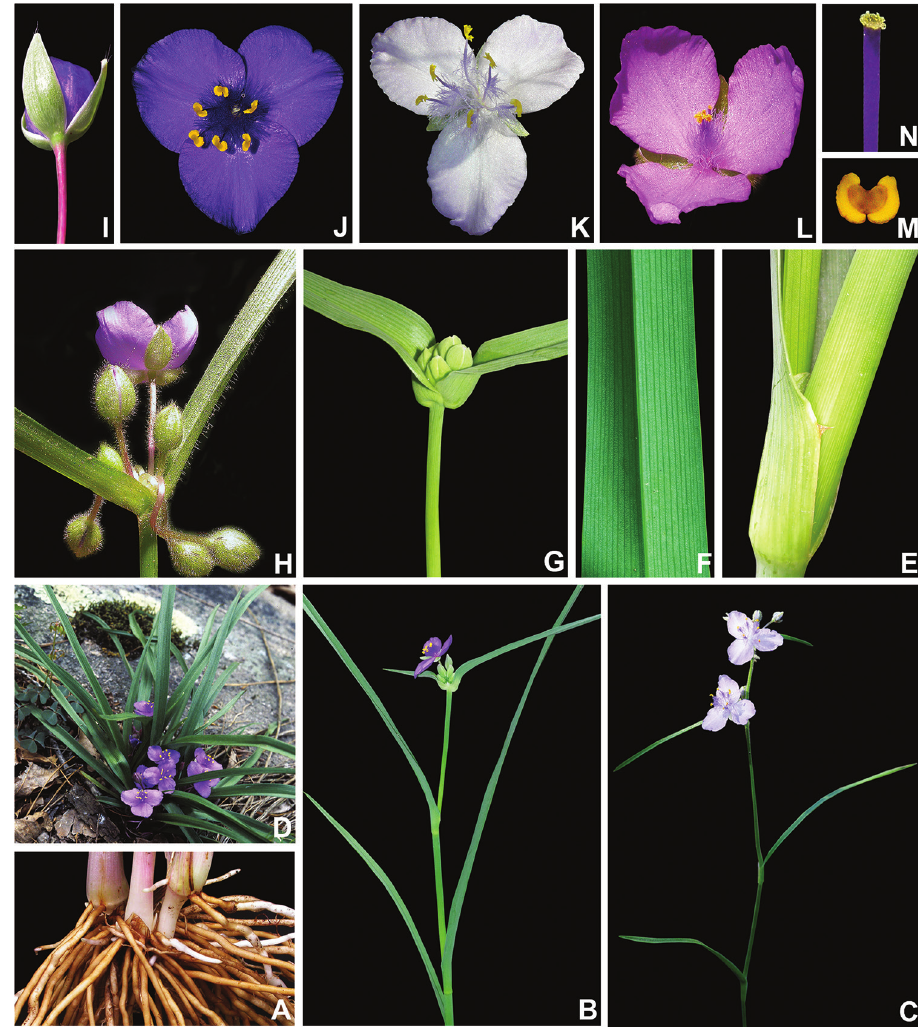
Figure 14. Tradescantia L. subg. Tradescantia . A tuberous roots of T. ohiensis Raf. B–D habit: B erect robust habit of T. ohiensis C erect delicate habit of T. pinetorum Greene D rosette habit of T. longipes E.S.Anderson & Woodson. E, leaf-sheath split at maturity of T. ohiensis F detail of the leaf-blade of T. ohiensis , showing the conspicuous secondary veins G–H inflorescence: G inflorescence of T. ohiensis , showing the saccate cincinni bracts H inflorescence of T. virginiana L., showing the non-saccate cin- cinni bracts and densely pubescent bracts, pedicels and sepals I floral bud of T. ohiensis , showing the non-gibbous pedicel apex J–L flowers: J front view of a flower of T. ohiensis K front view of a flower of T. pinetorum L oblique view of a flower of T. virginiana M anther of T. ohiensis , showing the quadran- gular and slightly curved connective, and the C-shaped anther sacs. N, style of T. ohiensis , showing the capitate stigma. A–B, E–F, H–I, L by G. Davidse, C, K by R.W. Van Devender, D by B. Nellums, and G, J, M–N by M.O.O.